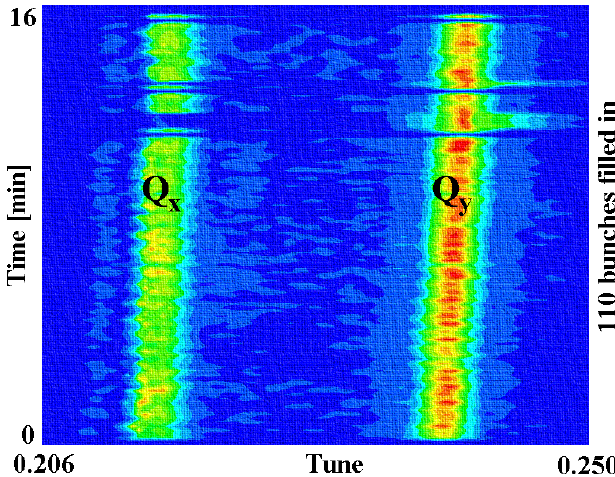
FIG. 6. (Color) Coherent tunes of the last injected bunch along a train of 110 proton bunches with 108 ns spacing in the Yellow ring. Because of coupling both transverse tunes are visible